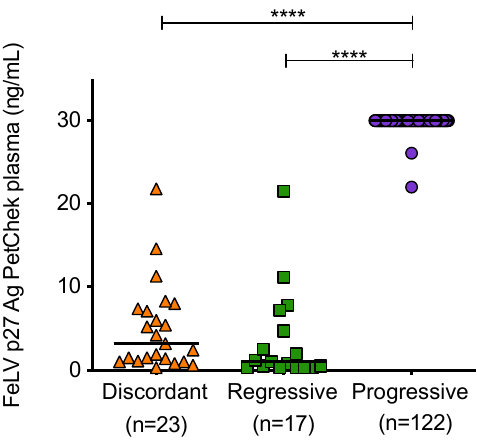
Figure 7. Plasma antigenaemia was measured using the IDEXX FeLV PetChek ® ELISA. Each point represents the p27 capsid antigen (Ag) concentration in samples from cats in the three categories. Samples from uninfected cats tested p27 capsid antigen negative. Statistical significance was determined using Kruskal–Wallis and Dunn’s multiple comparisons tests ( p -value < 0.0001 ****). When p27 capsid antigen concentrations were compared over time, it was observed that the concentration of antigen in plasma decreased significantly between the two time points in discordant cats (Figure 8). High antigen concentrations were maintained in cats with progressive infection.